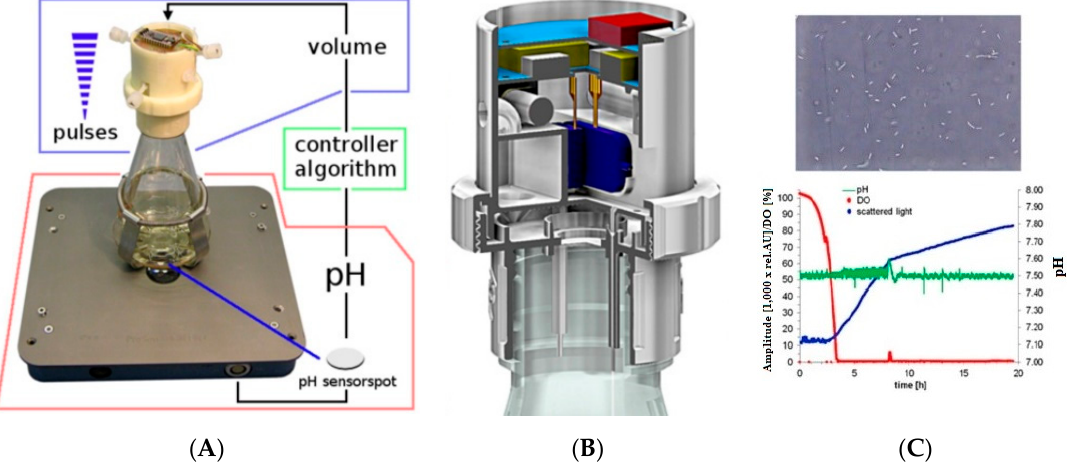
Figure 5. Continuous recalibration of the 3D-printed Control Unit Adaptive P controller. Reproduced from Ude et al. [127] . ( A ) The 3D printed flask is used to control the pH of the solution using defined algorithm. ( B ) The interior of th3 3D printed flask. ( C ) Variation in the amplitude, pH levels and intensity of the scattered light with time